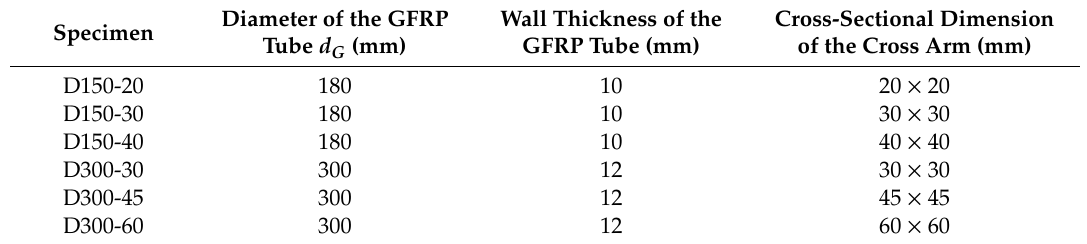
Figure 1. Specimen geometry and dimensions (unit in mm, not to scale): ( a ) Front view; ( b ) top view; ( c ) schematic diagram. Table 1. Specimen dimensions.